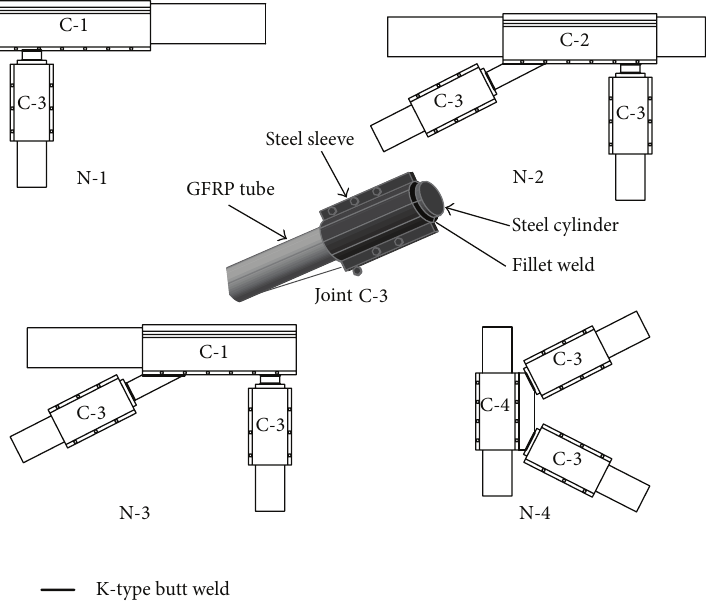
Figure 7: Different types of nodes welded by joint C-3 and other